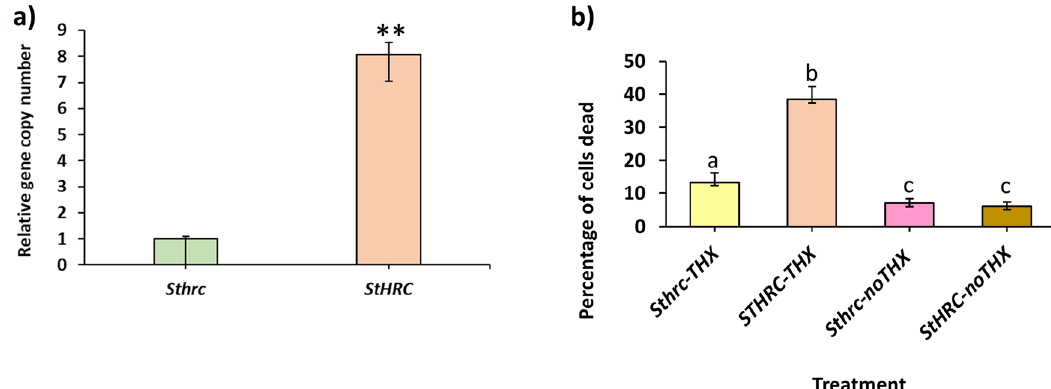
Figure 4. Russet Burbank potato plants or their protoplasts, possessing functional and mutated histidine rich Ca 2+ binding protein ( StHRC or Sthrc ), inoculated with S. scabiei or Thaxtomin-A. ( a ) RB potato with StHRC and Sthrc inoculated with S. scabiei : pathogen biomass. ( b ) TUNEL assay of RB potato protoplasts, with StHRC and Sthrc , inoculated with Thaxtomin-A toxin, produced by S. scabiei . Significance calculated based on Student’s t-test P value: **p < 0.01, *p < 0.05 or based on multiple comparison tests. Values are average of three replicates for pathogen biomass quantification and five replicates for TUNEL